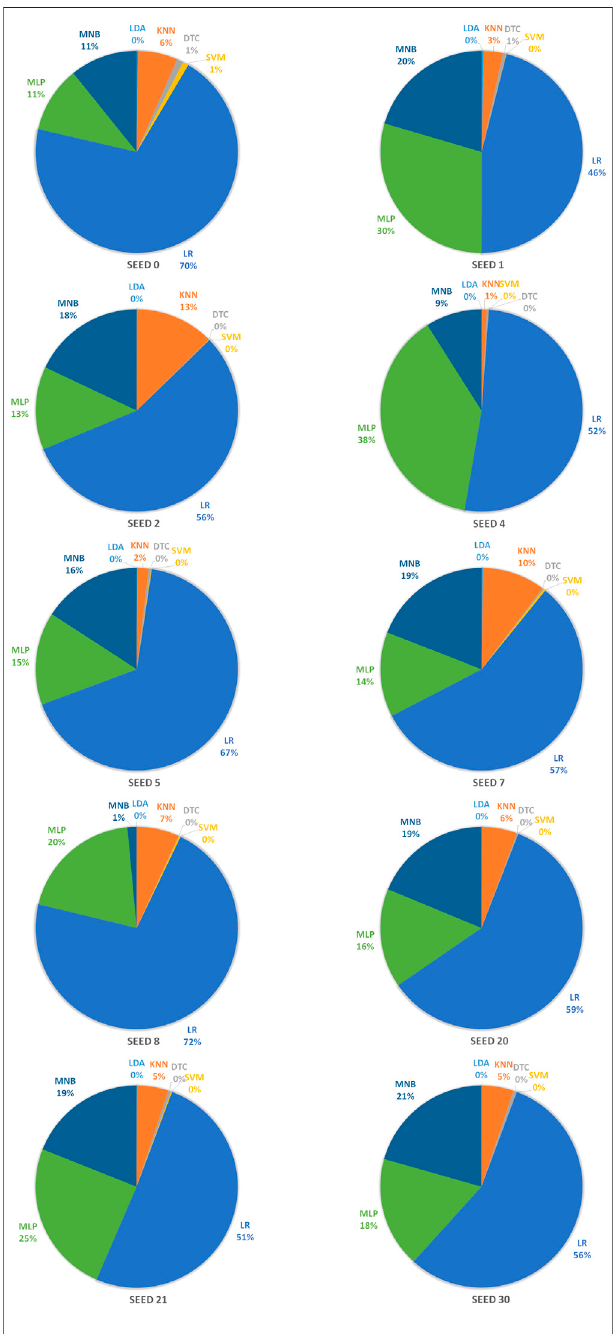
FIGURE 4 | Pie charts representing the contribution of seven base classi fi ers according to ten times of the sample division.